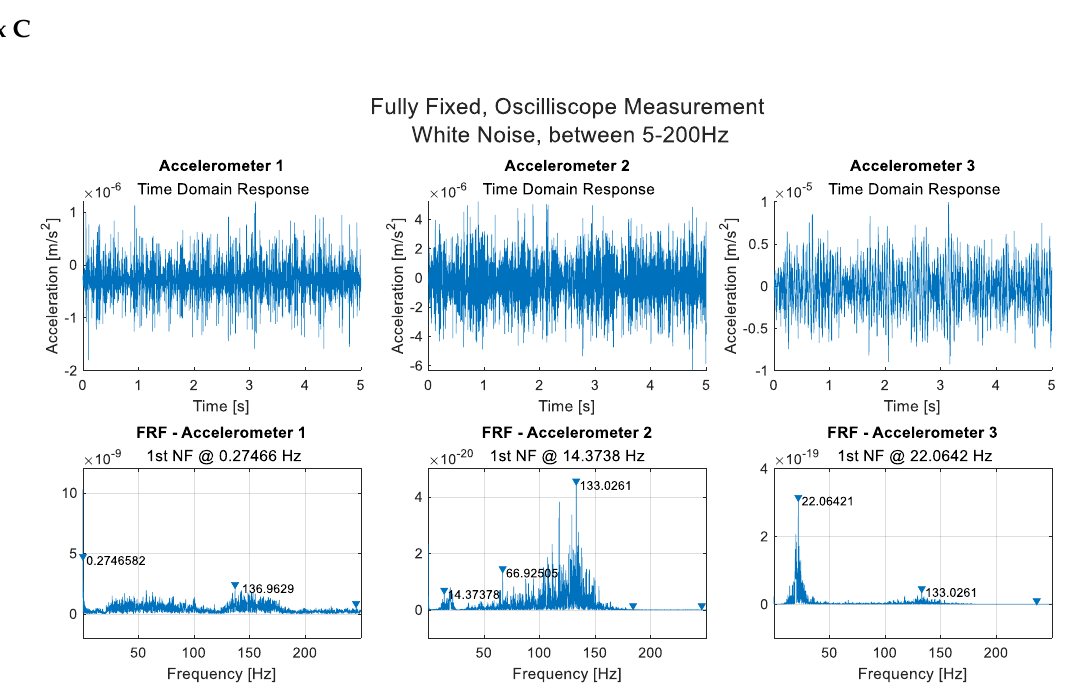
Figure A 2. Close-up around first natural frequency, Arduino measurement white noise input, FRF and power spectrum plots, accelerometers 2 and 3 .